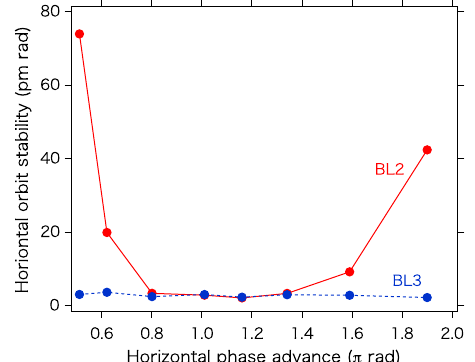
FIG. 5. Normalized horizontal projected emittance after the BL2 dogleg calculated as a function of the horizontal phase advance between the two DBA structures. Initial conditions of the electron beam are the same as Fig. 4.